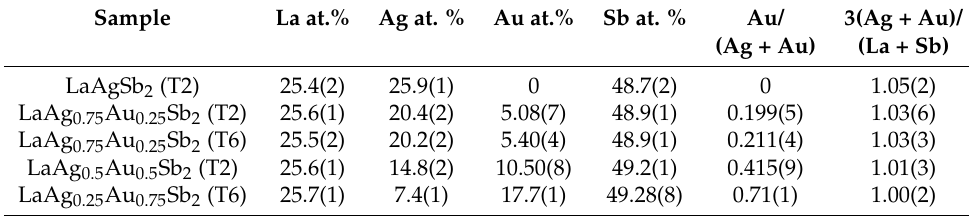
Table A3. EDS results for LaAg 1 − x Au x Sb 2